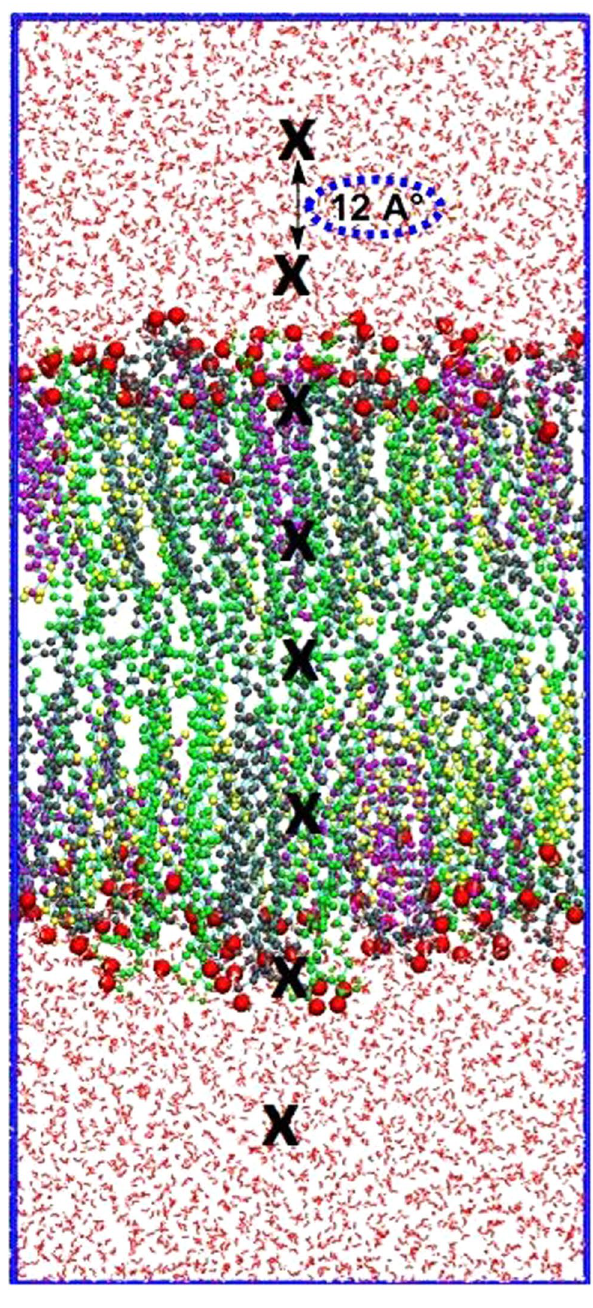
Figure 2. Illustration of the US simulation set-up. Eight umbrella windows separated by 12 Å (position of ROS depicted by block crosses) are sampled in one simulation. In consecutive simulations, each species is shifted by 0.12 Å. To sample the entire membrane system, 33 simulations are performed, yielding a total of 264 umbrella histograms from which a PMF is